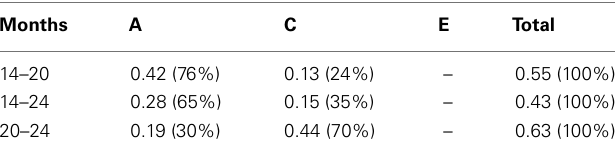
Table 7 | Covariance (%) between negative emotionality across age explained by genetic and environmental